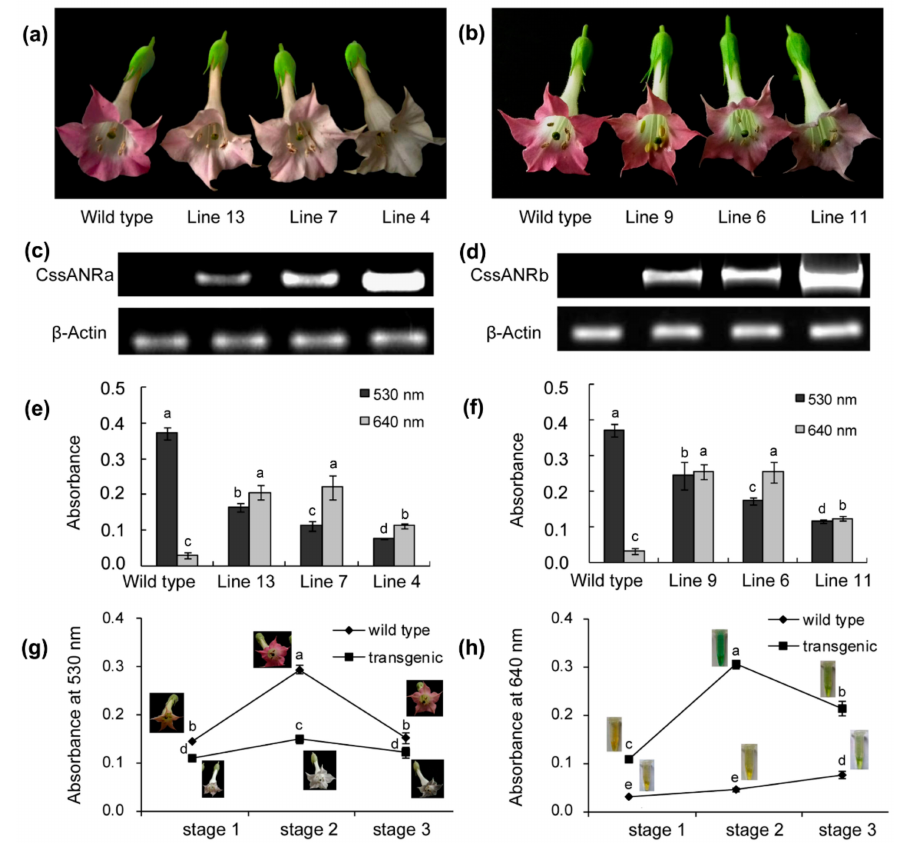
Figure 7. Ectopic expression of CssANRa and CssANRb genes in tobacco flowers. ( a , b ) pigmentation phenotypes of CssANRa ( a , three lines) and CssANRb ( b , three lines) transgenic vs. wild-type tobacco flowers fully opened, ( c , d ) gel images showing expression of CssANRa ( c ) and CssANRb ( d ) transgene fragments amplified from fully opened flowers by semi-quantitative PCR; ( e ) anthocyanin and PA levels in CssANRa transgenic vs. wild-type flowers estimated at 530 nm and 640 nm, respectively; ( f ) anthocyanin and PA levels in CssANRb transgenic vs. wild-type flowers estimated at 530 nm and 640 nm, respectively; ( g , h ) dynamic patterns of anthocyanins ( g ) and PAs ( h ) levels at three selected development stages of CssANRa transgenic flowers. In ( e , f ), bars labeled with different low case letters for anthocyanin or PAs mean significant difference ( p -value less than 0.05), while with the same ones mean insignificance ( p -value higher than 0.05). In ( g , h ), points labeled with different low case letters mean significant difference ( p -value less than 0.05), while with the same ones mean insignificance ( p -value higher than 0.05). p -Values were calculated with Student’s t